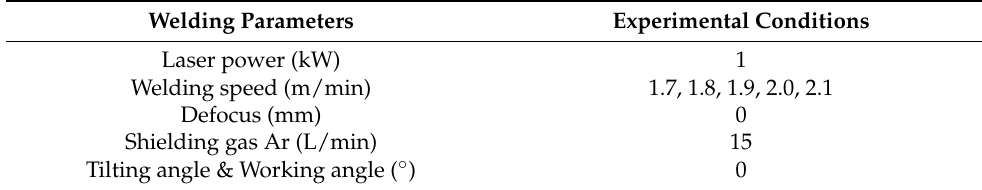
Table 4. 2nd Conditions of laser welding for 0.25 mm thickness of ASTM F1684.